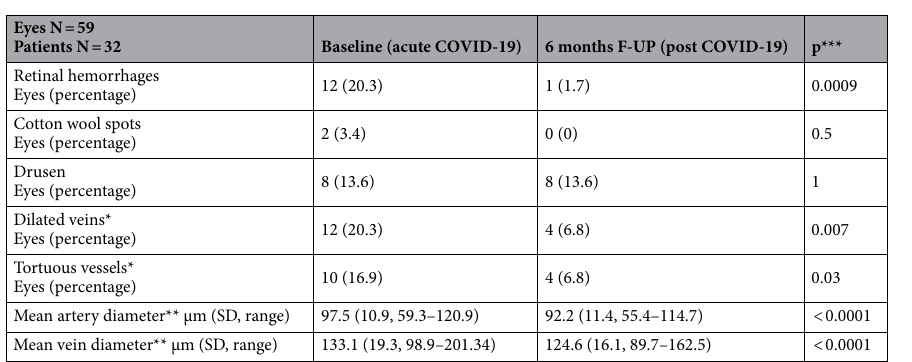
Table 3. Retinal findings in subjects included in the study at baseline and follow-up. COVID-19 Coronavirus disease 2019, SD standard deviation. *According to qualitative evaluation performed by the ophthalmologists. **Measured using the semi-automatic computer assisted method. ***McNemar Test for qualitative variables, linear mixed model for repeated measurements accounting for nesting of eyes within subjects for continuous